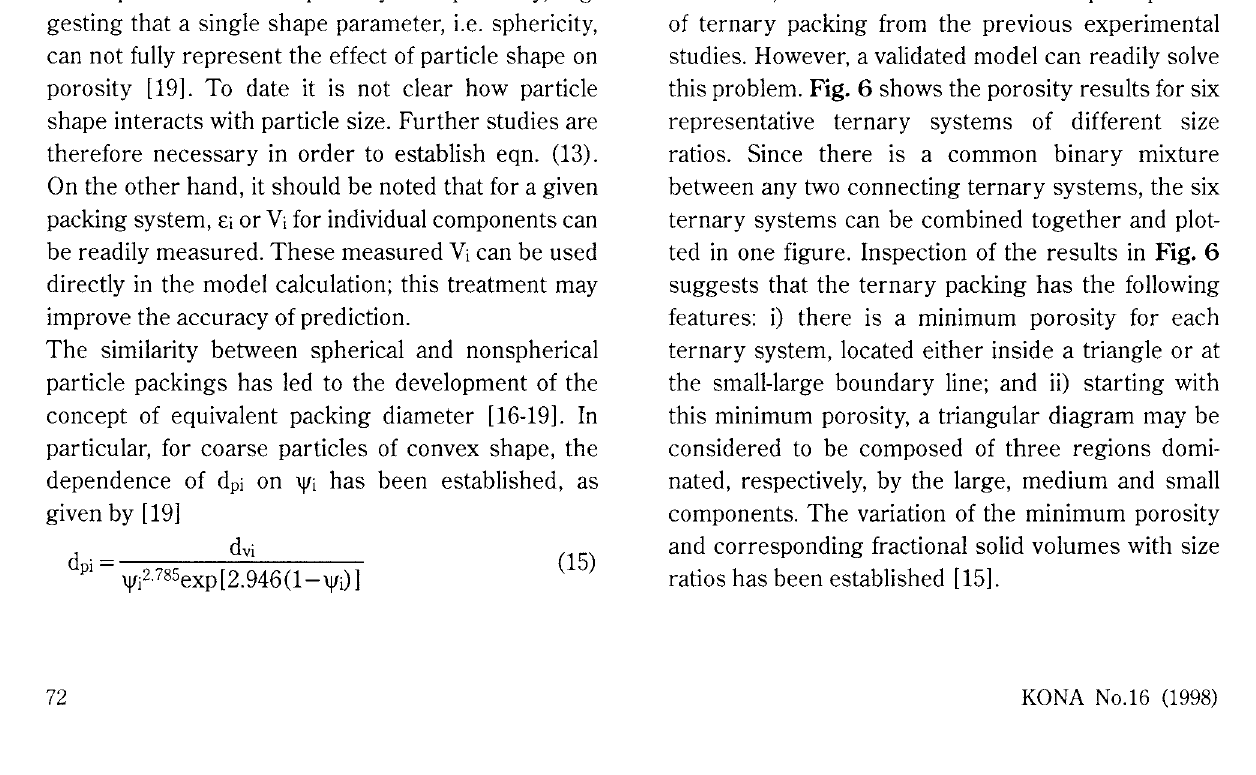
Initial porosity vs. particle shape under the loose packing condition